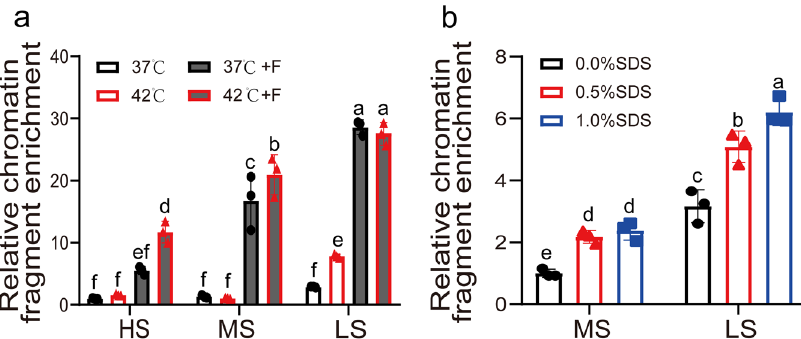
Fig. 2 Determination of the suitable hybridization buffer for R-ChIP. a Analysis of the ef fi ciency of different hybridization buffers. Six hybridization buffers were studied, including HS (high salt), MS (medium salt), and LS (low salt) buffer, with or without 10% (v/v) formamide. Hybridization was performed at 37 °C or 42 °C. + F: supplement with 10% (v/v) formamide. The enrichment data using HS buffer at 37 °C was set as 1 to normalize other enrichment data including using the other hybridization buffers. b Analysis of the effects of SDS on DNA hybridization ef fi ciency. MS and LS hybridization buffers containing 10% (v/v) formamide were, respectively, supplied with 0, 0.5%, or 1% (w/v) sodium dodecyl sulfate (SDS) for hybridization. The enrichment data using MS buffer and 0% (w/v) SDS was set as 1 to normalize the enrichment data using the other hybridization buffers. Three replicates (sample size of 50 seedlings) were performed ( n = 3 independent experiments). Error bar indicates standard deviations of the mean measurements. Multiple comparisons of means were performed using Tukey ’ s test, and different letters represent signi fi cant differences among treatments ( P < 0.05). The promoter region of AtCAT3 used for the qPCR evaluation was site 1 and is shown in Fig. 7l and Supplementary Data 4. The promoter of AtActin3 was used as the internal control (which is far away from the promoter of AtCAT3 ).